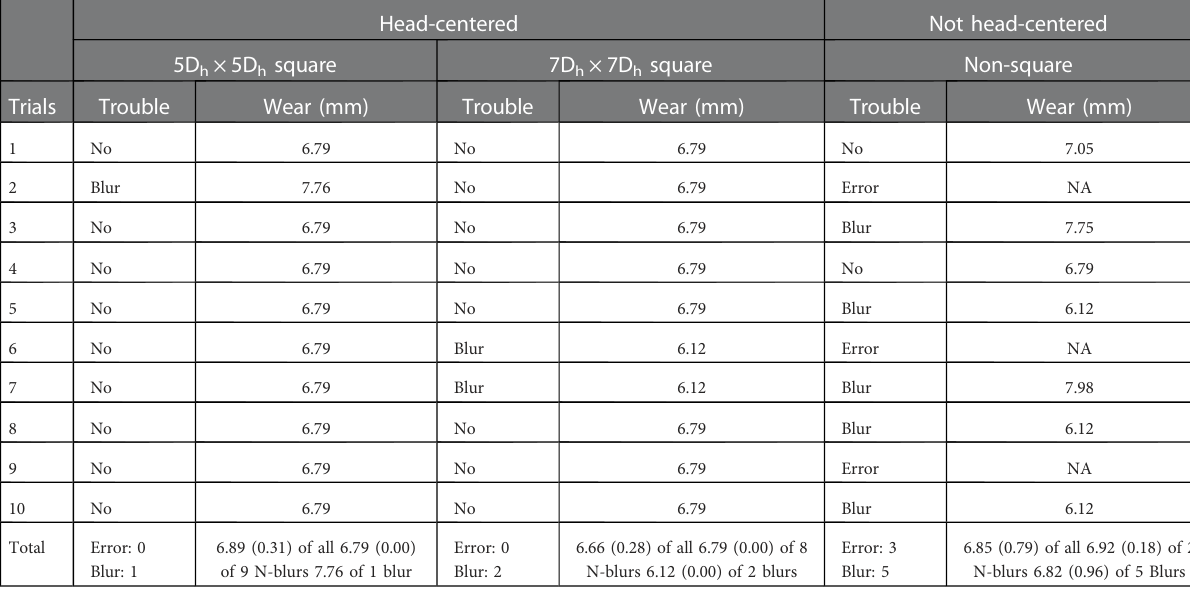
TABLE 3 The measured wear for different area speci fi cations (true wear=6.67 mm).